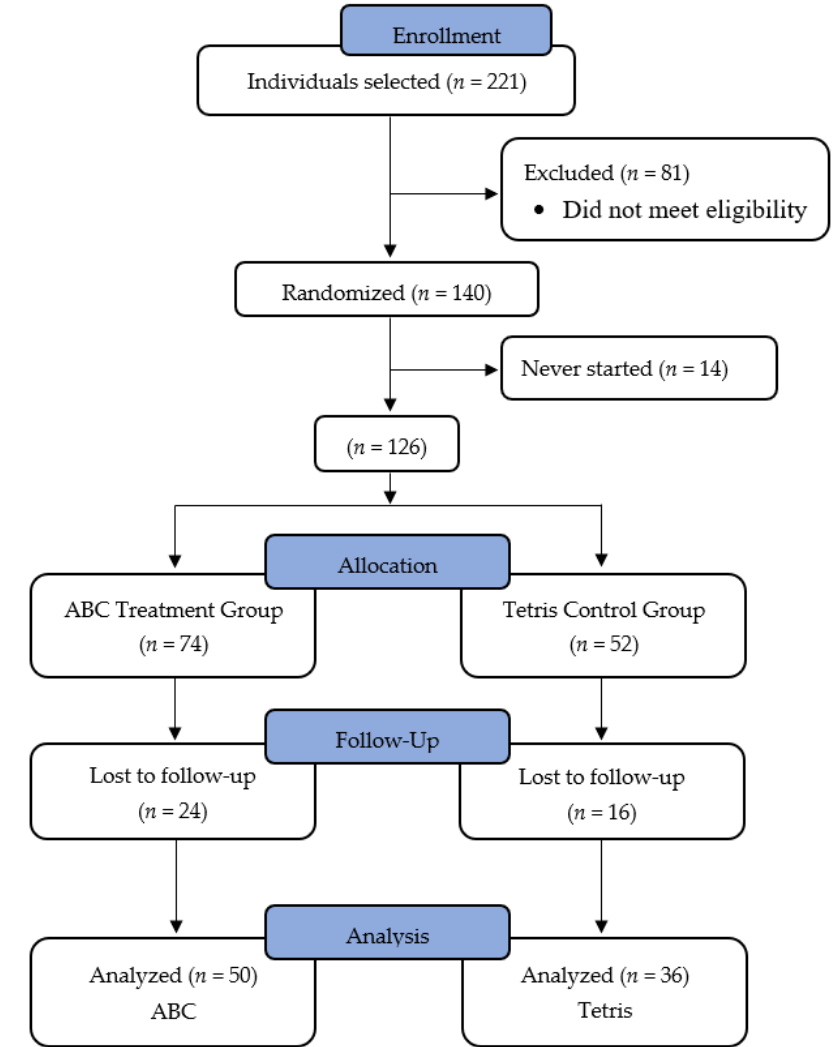
Figure 1. Flow chart of participant enrollment and attrition. 221 individuals initially enrolled in the study. After screening and withdrawals, a total of 86 participants (ABC: n = 50; Tetris: n = 36) remained in the final sample for analyses.